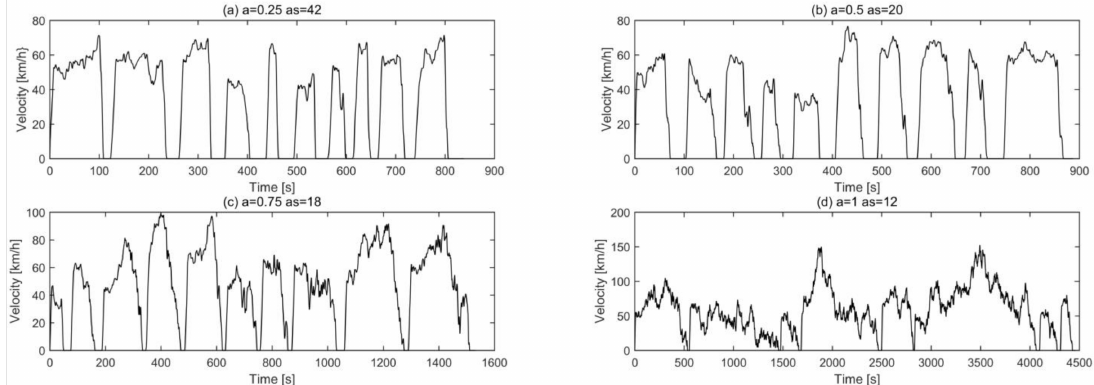
Figure 16. Generating DCs with different acceleration granularity.